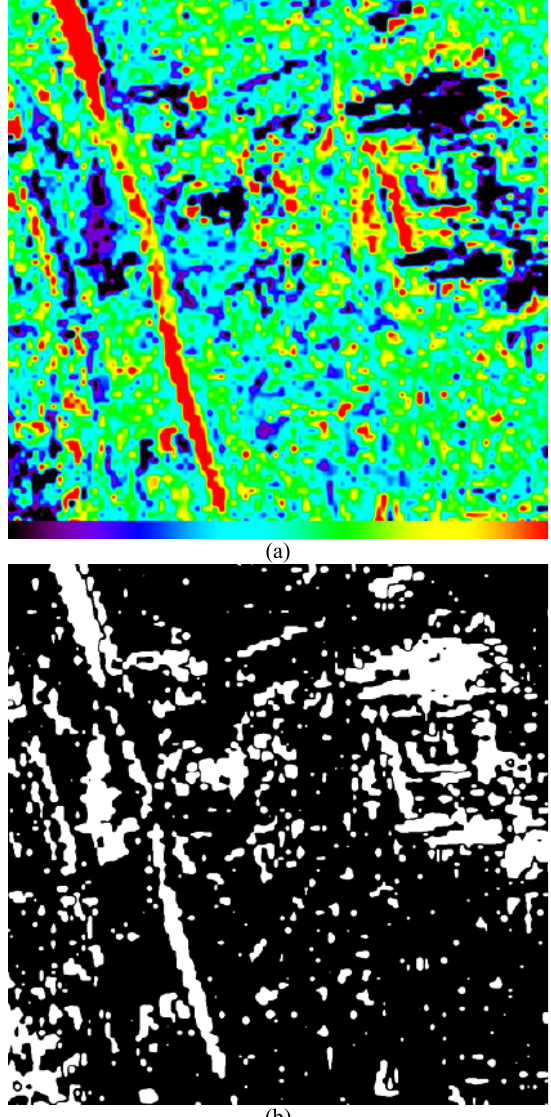
Figure 7. Multi-looking example. (a) Ratio image (potential changes towards black and red). (b) Detected changes